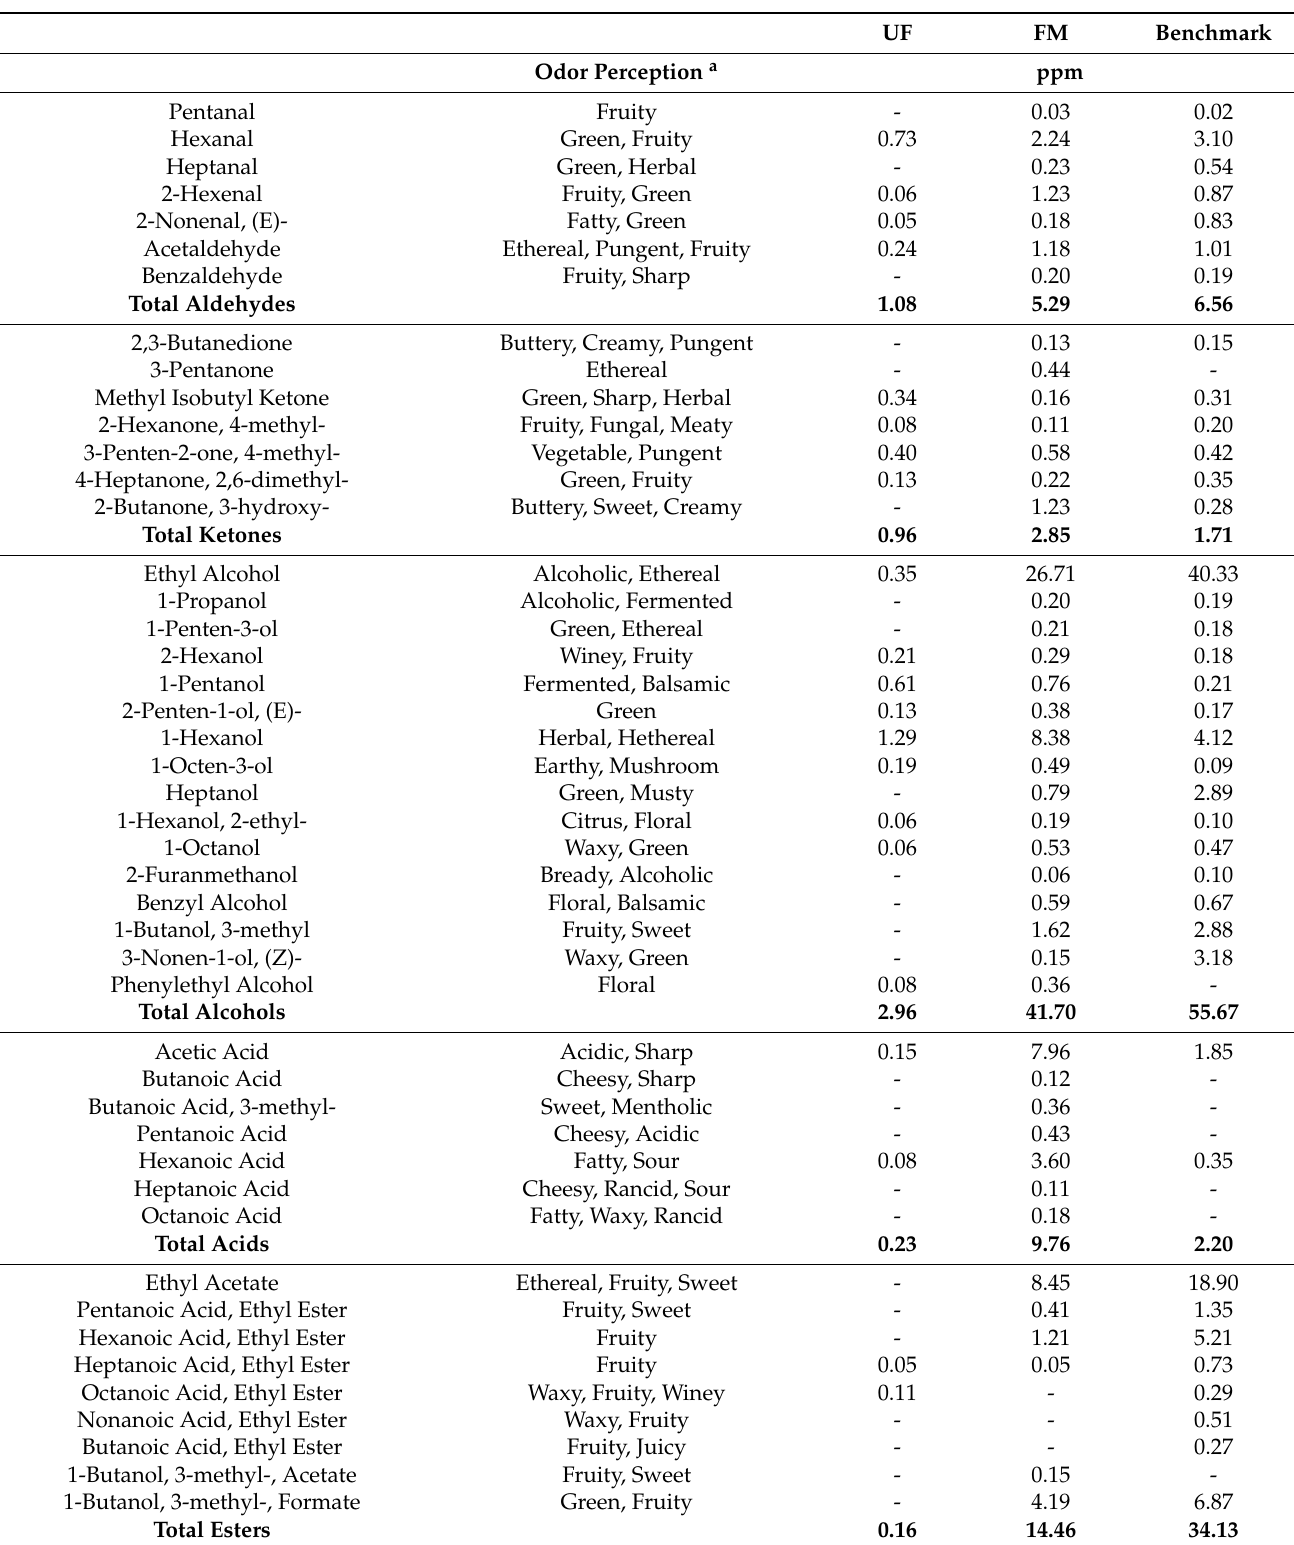
Table 6. Volatile compounds, expressed as ppm, detected through GC-MS-SPME in preferments FM, benchmark, and the mixture of unfermented milling by-products (UF). The coefficients of variability, expressed as the percentage ratios between the standard deviations and the mean values, ranged between 2% and